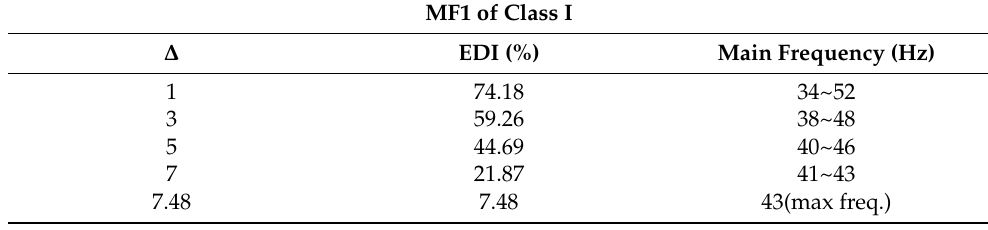
Table 4. The MF1 of class I, EDI, main frequency band, and maximum frequency for threshold ∆ = 1%, 3%, 5%, and 7%.